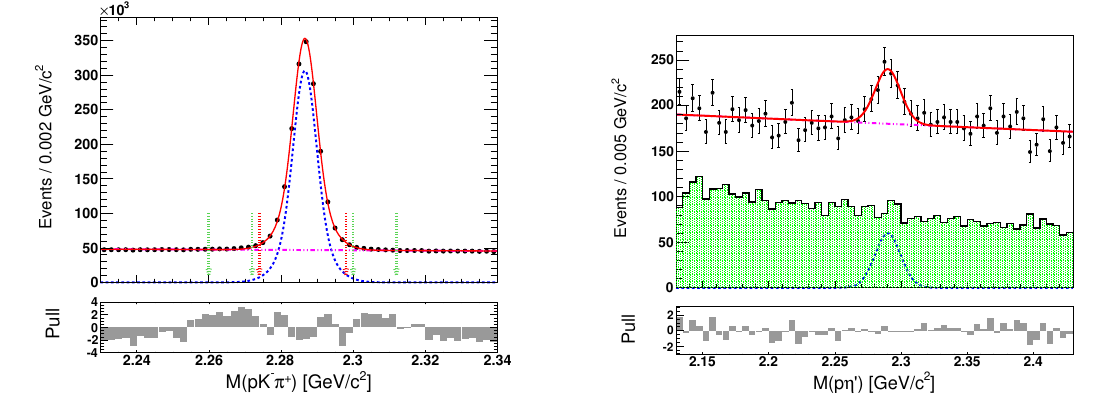
Figure 2 . Fits to the invariant mass distributions of the pK − π + (Left) and pη 0 combinations (Right). Black dots with error bars represent the data; red solid lines represent the total fitted result; blue dashed lines represent the signal shape; magenta dot-dashed lines represent the background shape; and the green histogram is from normalized η 0